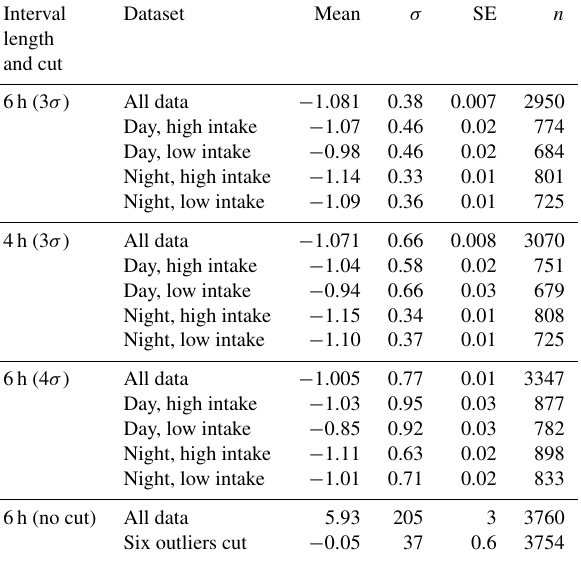
Table 2. Table of average values for all slopes and four data sub- sets. σ is 1 standard deviation, SE is the standard error of the mean √ n ), and n is the number of slope values surviving the iterative ( σ/ cut. Interval